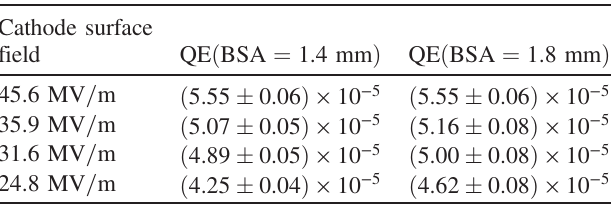
FIG. 8. Bunch charge jitter in the